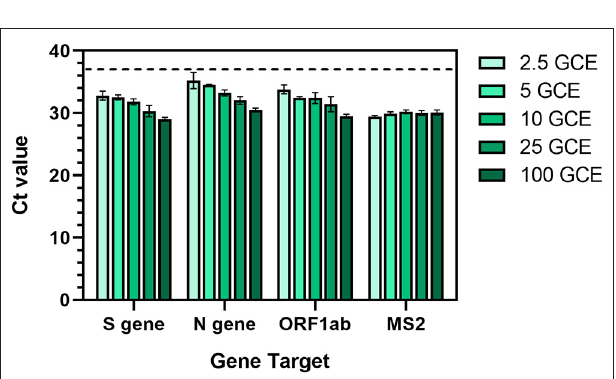
FIGURE 4 | Characterization of Thermo Fisher TaqPath TM RT-PCR COVID-19 assay using contrived positive saliva samples with a range of SARS-CoV-2 genomic copy equivalents (GCE). An equal amount of MS2 phage was added to each sample as an extraction control. Values represent Ct values ± standard deviation of three reactions. Dotted line represents the detection threshold (Ct =